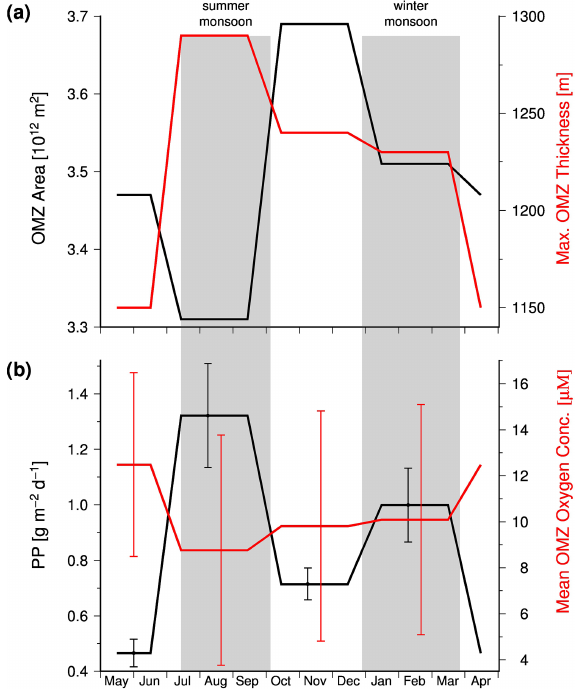
Figure 5. (a) The mean seasonal areal extension and maximum thickness of the Arabian Sea OMZ. (b) Seasonal mean satellite- derived primary production which was obtained from the ocean primary production website (http://www.science.oregonstate.edu/ ocean.productivity/, last access: 15 August 2020) and the seasonal mean oxygen concentration within the Arabian Sea OMZ. The satellite data covered the period between 2002 and 2019 and were averaged seasonally for the Arabian Sea north of 10 ◦ . The OMZ data are obtained from Table 5 in Acharya and Panigrahi (2016).